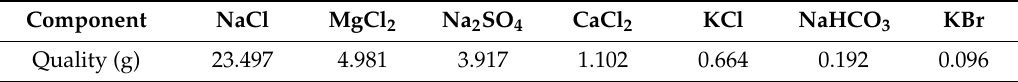
Table 2. Synthetic seawater formula (Note: Diluted with water to 1000 g).